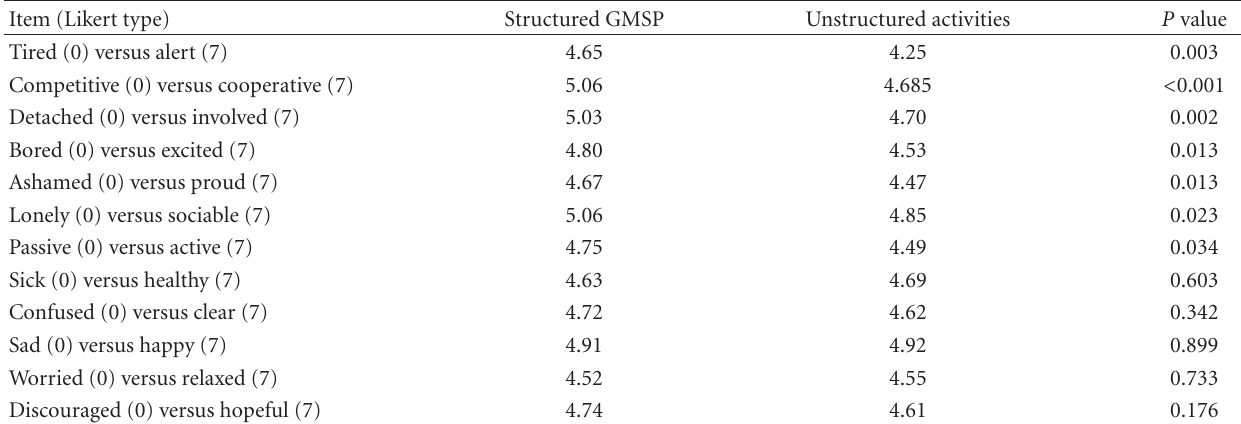
Table 3: E ff ect of GMSP activity on student feelings while in